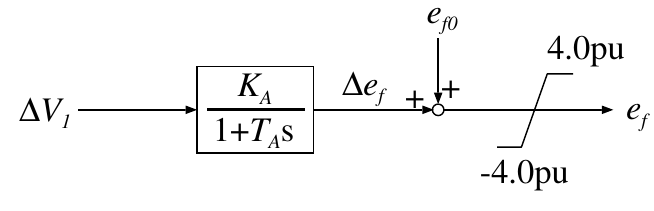
Figure 2. Automatic voltage regulator. Table 1. Parameters of thermal power generators.